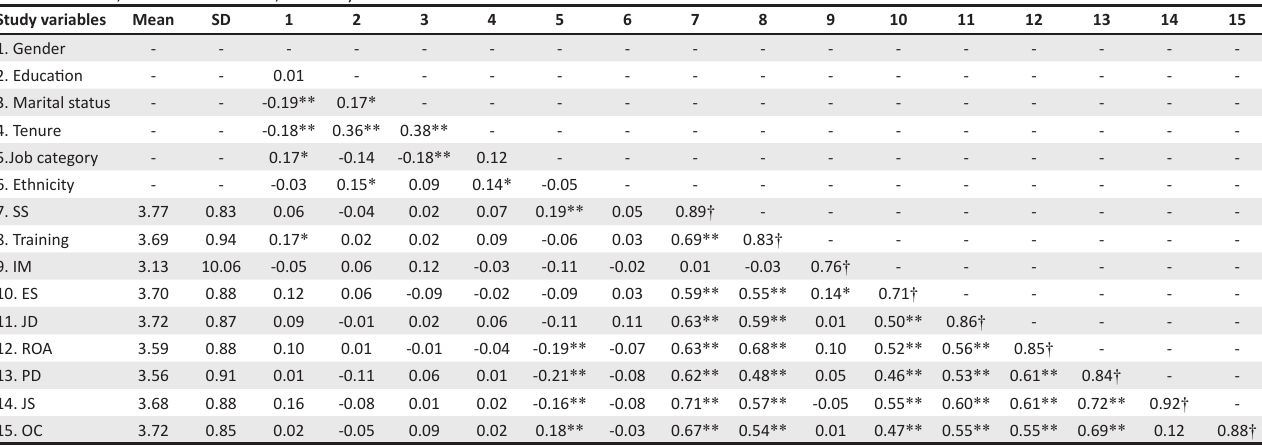
TABLE 5: Means, standard deviations, reliability coefficient and correlations. Study